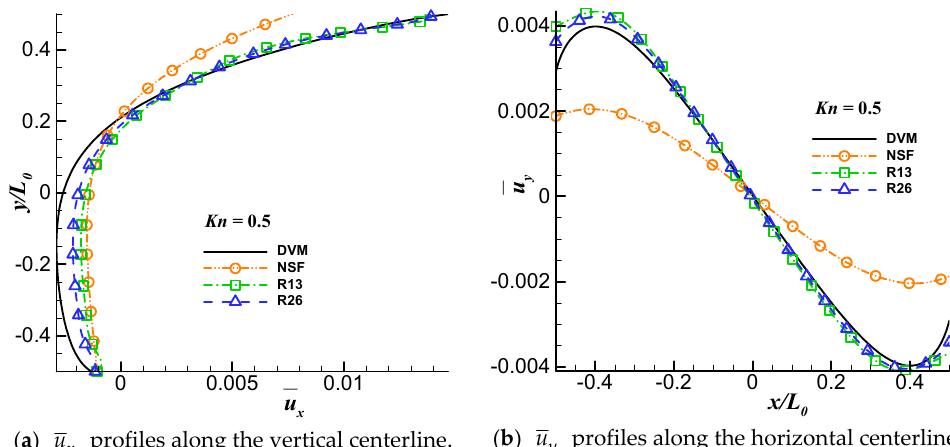
Figure 8. The simulation results of the cavity flow at = 0 5 Kn . .